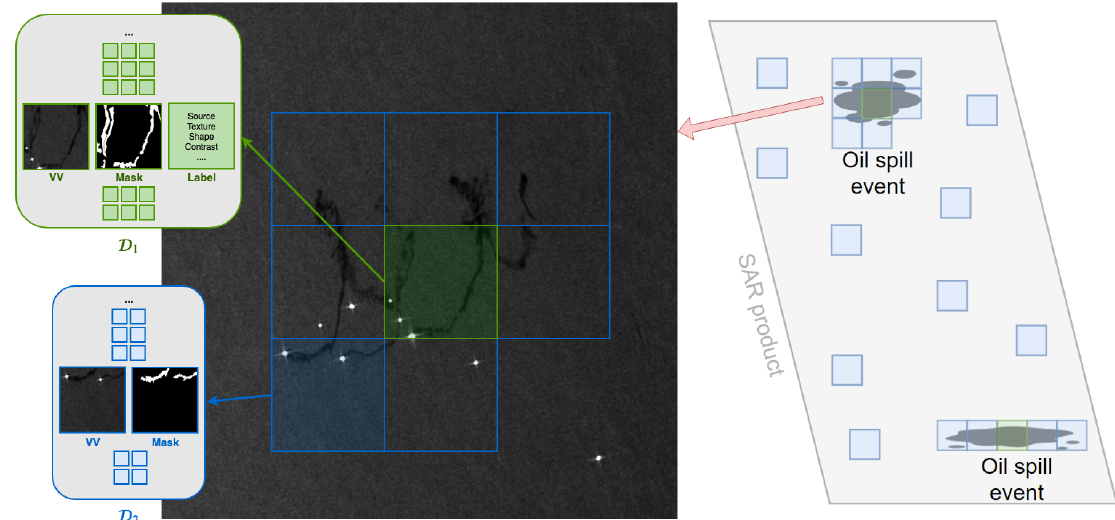
Figure 2. Illustration of patches extraction from the SAR products. The patches centered on the oil spill events (depicted in green) form the dataset D 1 and are associate with a label that indicates the values assumed by the 12 categories. The second dataset, D 2 , contains (i) all the patches of D 1 , (ii) all the patches with at least 1 oil spill pixel, (iii) an equal amount of patches without oil that is randomly sampled from other locations in the SAR product. Along with the VV channel, the segmentation masks are included in both